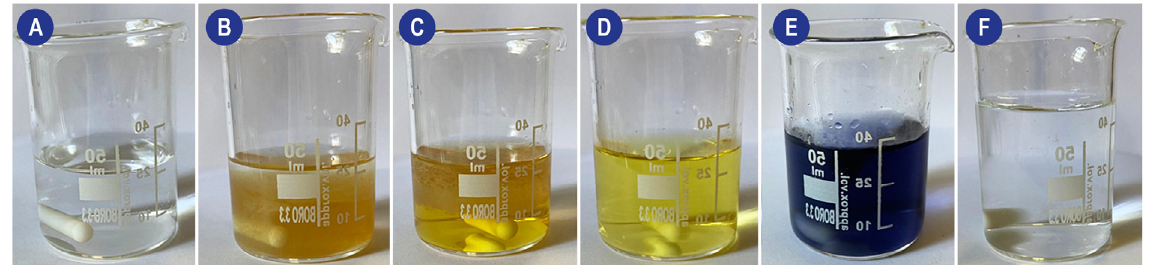
Figure 3. Schematic of the visual changes occurring during a Winkler method-based titration of a perfusion solution. ( A ) Perfusion solution ( B ) Addition of Mn, KI, and KOH (turbid solution with MnO(OH) 2 precipitate). ( C ) Addition of H 2 SO 4 ( D ) Characteristic straw yellow color obtained during iodine titration. When reached, the starch indicator must be added to the system. ( E ) System after the addition of the starch indicator. ( F ) System at the end of titration.